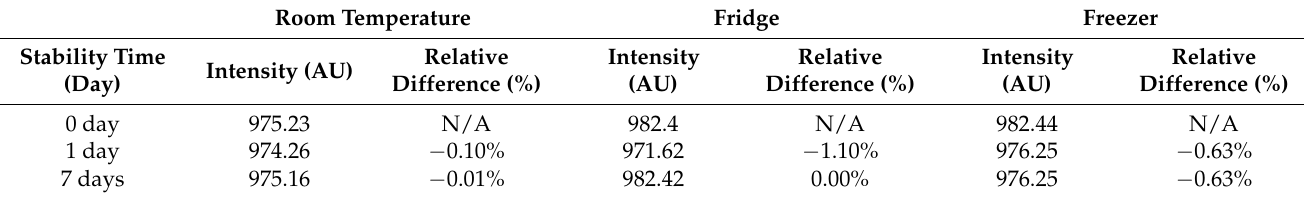
Table 11. Stability of the standard solution 1.25 µ g/mL stored at the different temperatures: room temperature, fridge, and freezer, as analyzed by fluorescence spectroscopy